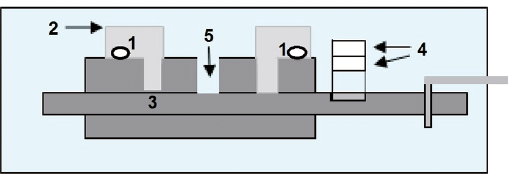
Figure 1: Details of suceptor used for growing the samples. 1) Elemental source, 2) quartz container, 3) slide strip holder, 4) GaAs and GaSb substrates, 5) purge